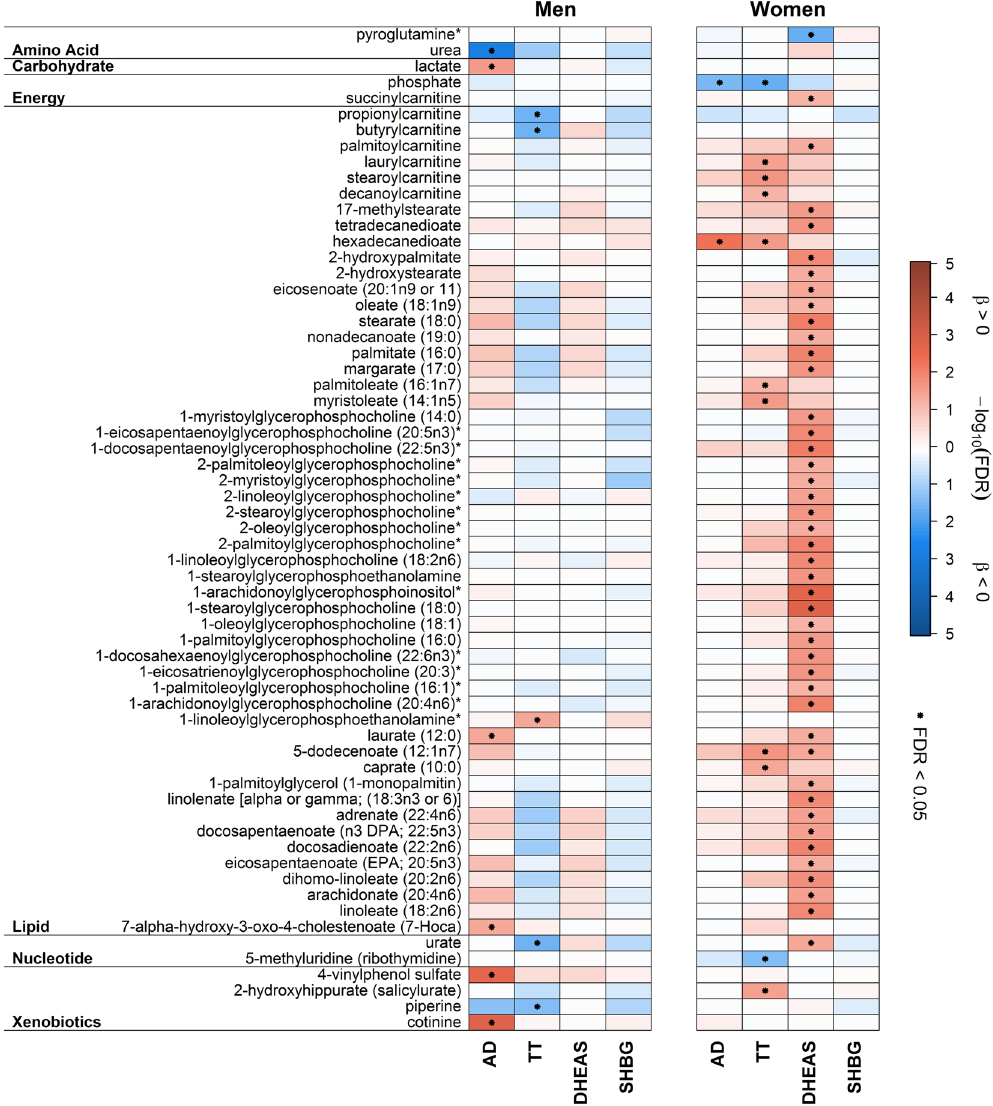
Figure 2. Heatmap of plasma metabolites, excluding steroids and unknown compounds, significantly associated in linear regression analyses with either androstenedione (AD), testosterone (TT), dehydroepiandrosterone sulfate (DHEAS) or sex hormone-binding globulin (SHBG) in men ( left panel ) and women ( right panel ), respectively. Orange shading denotes positive and blue shading inverse associations. Dots indicate significant associations by controlling the false discovery rate (FDR) at 5%. Metabolites were grouped according to physiological entities as denoted on the left. Corresponding estimates and FDR values from linear regression analyses can be found in Tables S1 and S2. * Metabolites were annotated based on fragmentation